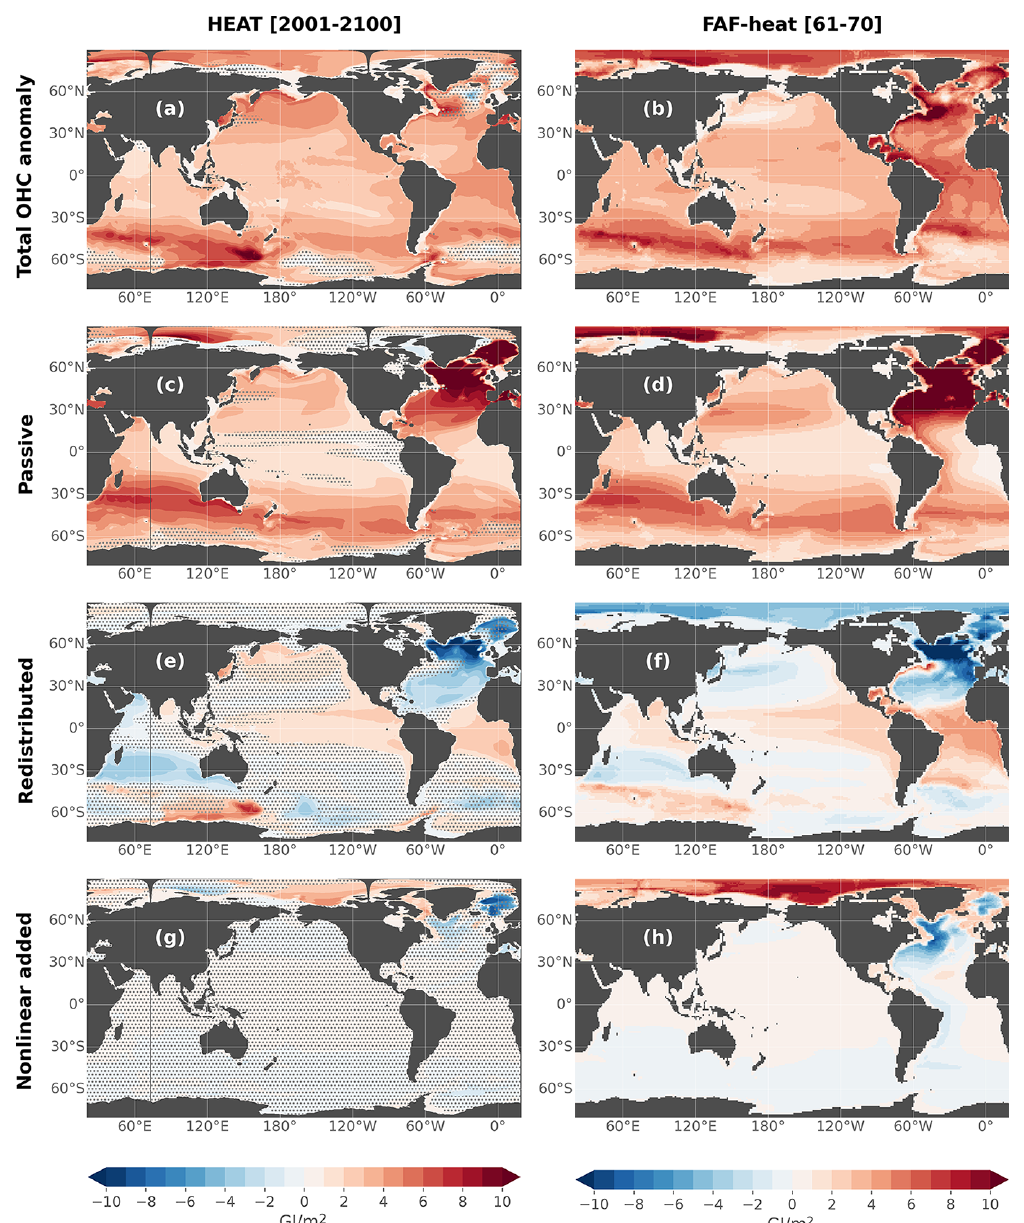
Figure 15. Decomposition of total, passive, redistributed and nonlinear added heat components (see text for definitions). Shown are the components for vertically integrated ocean heat content anomalies in the HEAT experiment in this study (a, c, e) and in the FAFMIP multi- model mean of Couldrey et al. (2021) ( b , d , f , which correspond to the data in their Fig. 12a, c, e, g). Anomalies are averaged over the period 2001–2100 for this study, and years 61–70 for the FAFMIP simulations. In (a) , (c) and (e) , stipples indicate where the anomaly is lower than twice the interannual standard deviation of the CTL